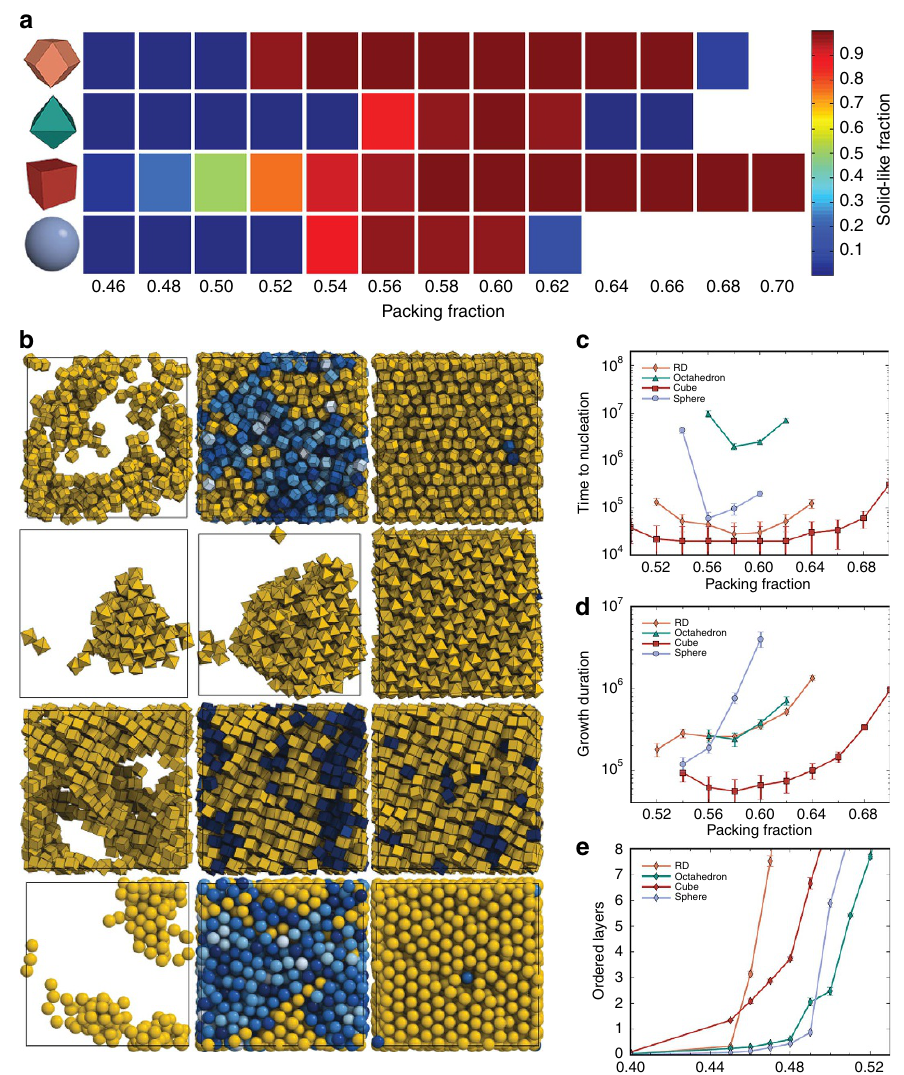
Figure 3 | Crystallization of nanocrystal superlattices in Monte Carlo simulations of hard particles. ( a ) Density range where homogenous nucleation and growth occurs for each particle shape using isochoric simulations starting from configurations rapidly compressed to a selected packing density. Rectangles in a density versus shape grid are coloured by the calculated system-average local order for rhombic dodecahedra, octahedra, cubes and spheres. Low values (blue) indicate disordered local structure (fluid), while high values (red) indicate crystalline order. Empty cells demarcate the regions beyond random close packing. Each data point represents the average of ten runs over 50 million Monte Carlo cycles. ( b ) Early, middle and late stage growth of homogeneously nucleating superlattices for rhombic dodecahedra, octahedra, cubes, and spheres. Densities are selected to represent a typical Monte Carlo trajectory for the particular shape. Crystallization may result from several nuclei. ( c ) Time to nucleate, as measured by the number of Monte Carlo cycles for the system to reach 20% crystallinity. ( d ) Time to grow, as measured by the time required to advance from 20 to 80% crystallinity. ( e ) Number of ordered layers equilibrated near hard boundaries at densities lower than where homogeneous nucleation occurs. The error bars in ( c – e ) correspond to the standard error of the